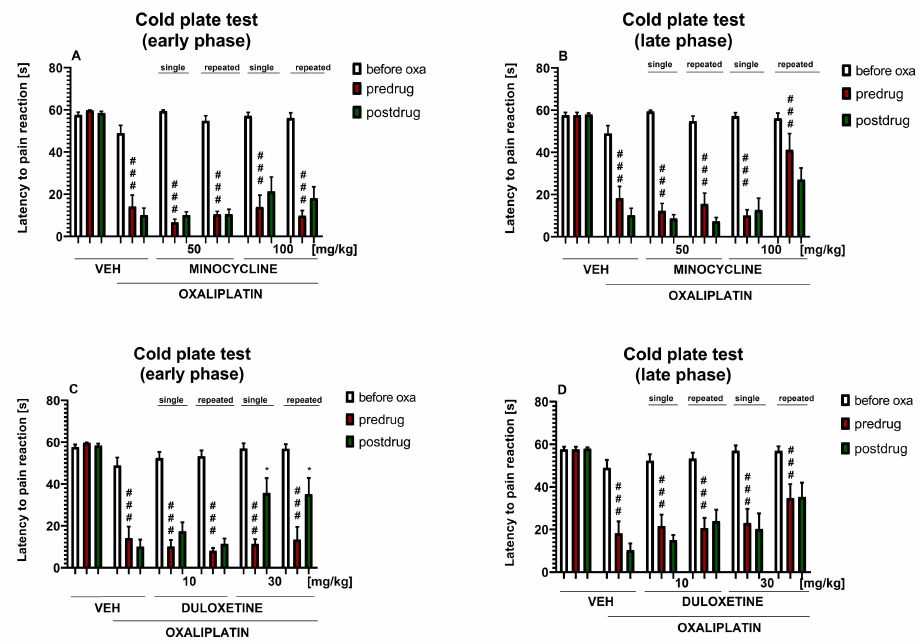
Figure 5. Effect of single-dose and repeated-dose minocycline and duloxetine, each used alone, on pain threshold in oxaliplatin-treated mice. Effect of minocycline (50, 100 mg/kg, i.p.) on cold hyperalgesia was measured in the cold plate test in mice on the day of oxaliplatin (oxa) administration ( A ) and 7 days later ( B ). Effect of duloxetine (10, 30 mg/kg, i.p.) on cold hyperalgesia was measured in the cold plate test in mice on the day of oxaliplatin administration ( C ) and 7 days later ( D ). The results are shown as the mean latency to pain reaction [s] ± SEM for n = 9–10. Statistical analysis: repeated measures ANOVA followed by Tukey’s post-hoc comparison. Significance: ### p < 0.001 vs. before oxaliplatin; * p < 0.05 vs. pre-drug latency to pain reaction in the individual group. In the figure titles ‘early phase’ ( A , C ) and ‘late phase’ ( B , D ) mean two time points at which the measurements were taken (day of oxaliplatin administration and day 7 after a single-dose oxaliplatin administration, respectively). Numerical values of the latencies to pain reaction ± SEM presented in this figure are shown in the Supplementary Materials (Table